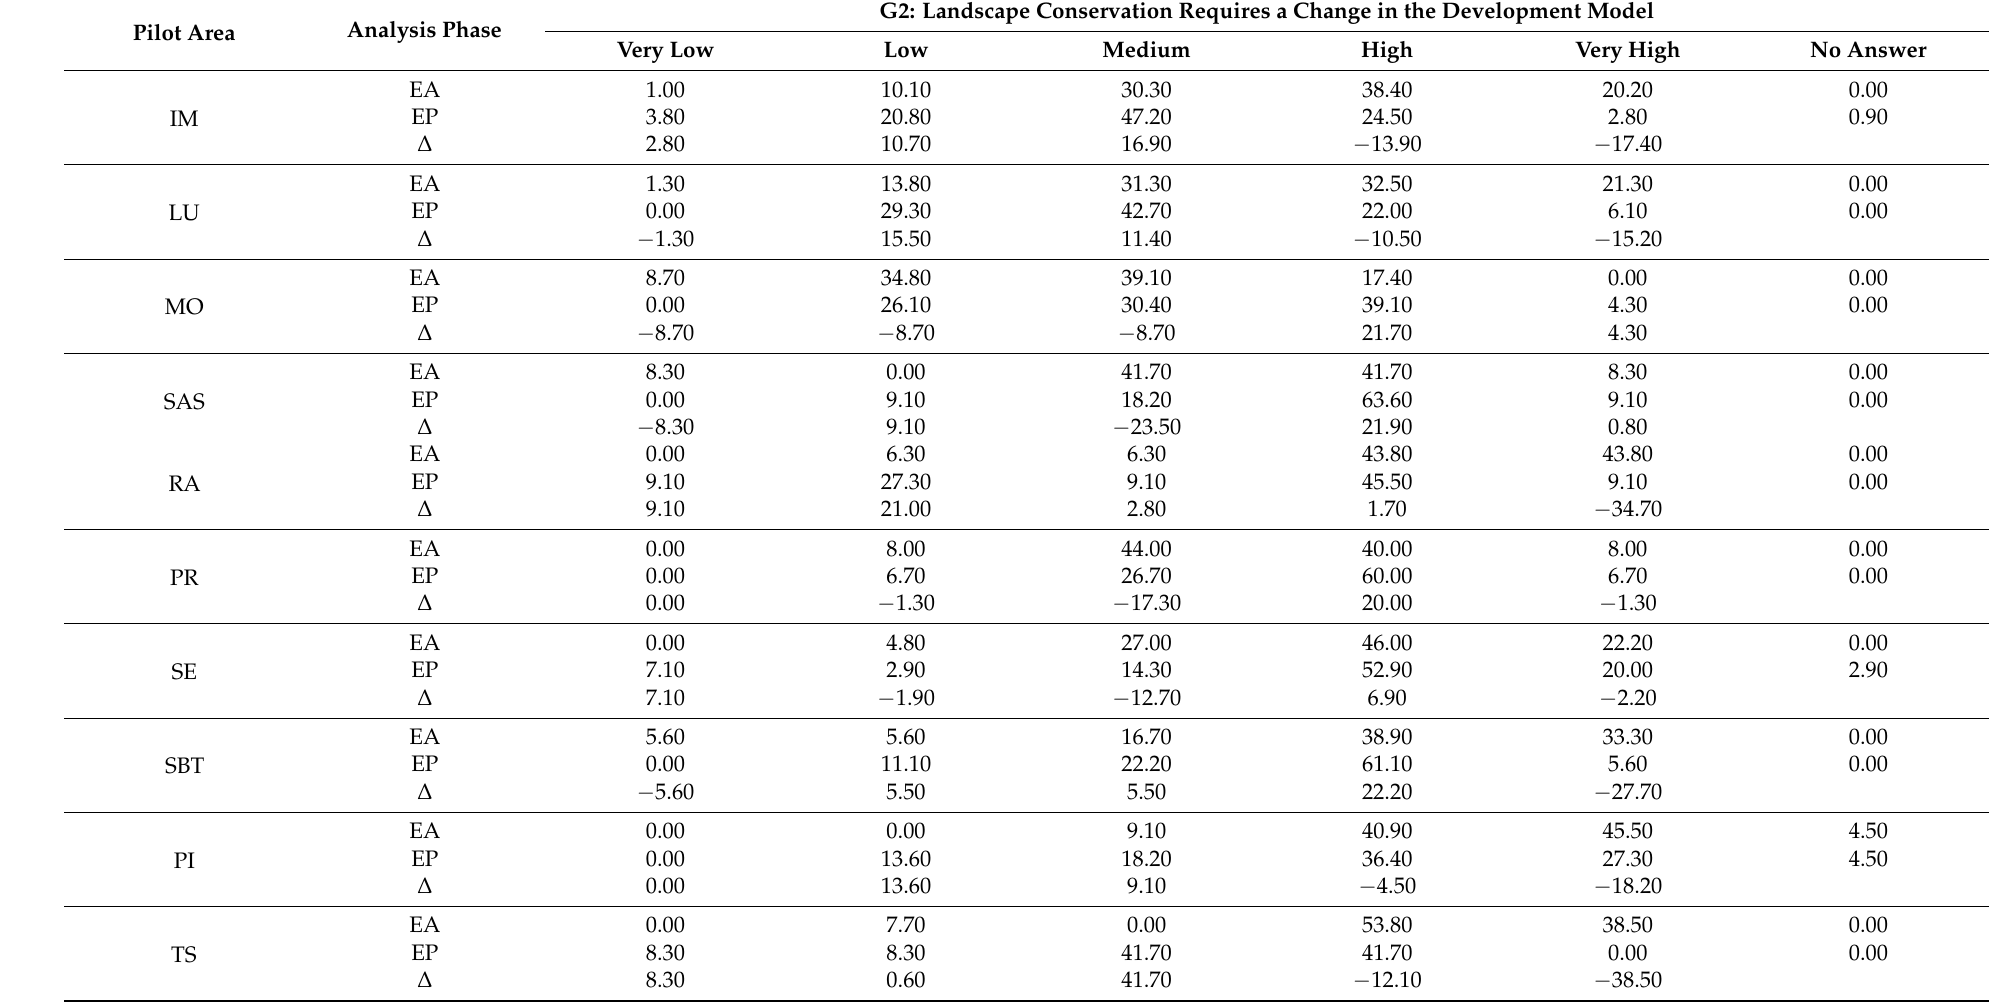
Table A3. Answers to the question G2 in percentages per each pilot area, in the ex-ante (EA) and in the ex-post (EP) phases, and their variation ( ∆